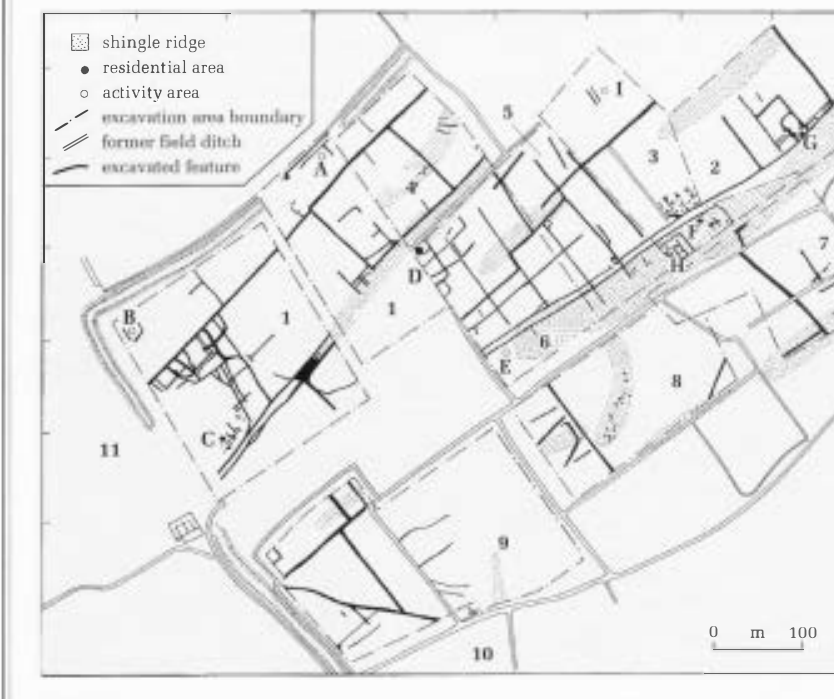
Plan of the excavated field system at Lydd Quarry (excavation stages 1-1 1) showing the location of residential and activity areas (A-I).